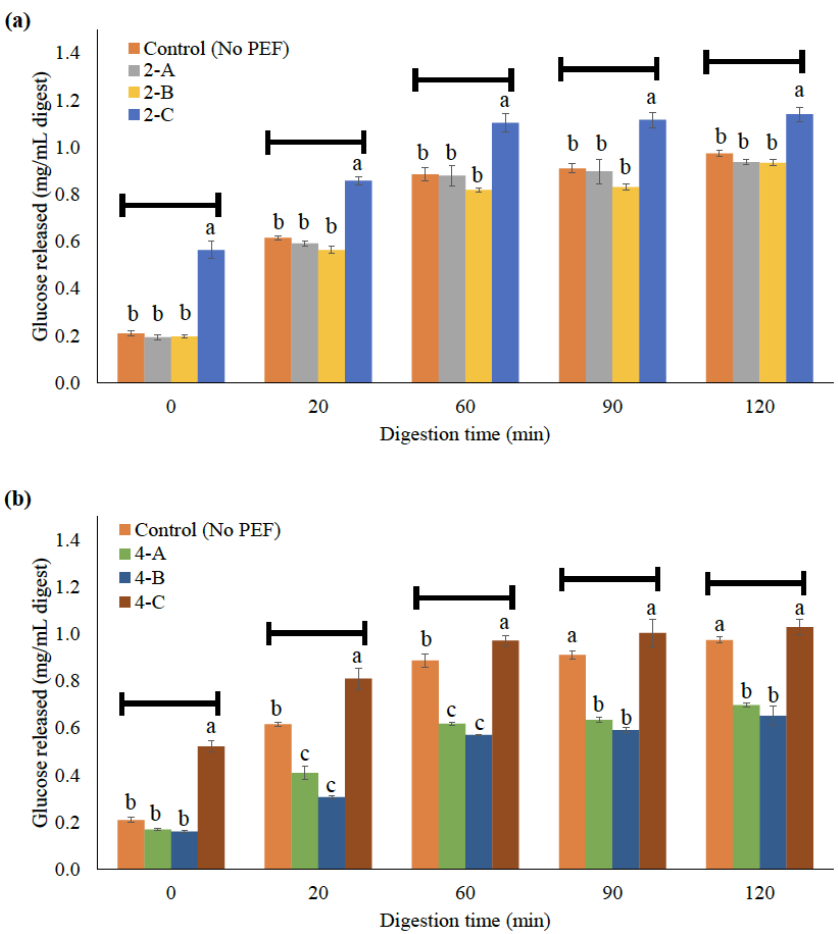
Figure 2. Glucose released (mg/mL digest) during the in vitro small intestinal digestion phase of PEF-treated oat flours ( n = 3). PEF treatment was applied at electric field strength levels of ( a ) 2.1–2.2 kV/cm and ( b ) 4.2–4.5 kV/cm. Specific energy input ranges from 52 to 53 kJ/kg (A), 216 to 218 kJ/kg (B), and 421 to 438 kJ/kg (C). Bars showing different letters indicate significant difference ( p < 0.05) between mean values of samples collected from the same time interval (e.g., Control vs. 2-A/B/C or Control vs. 4-A/B/C at time 0). Errors bars were generated using the calculated standard error of mean as positive and negative error